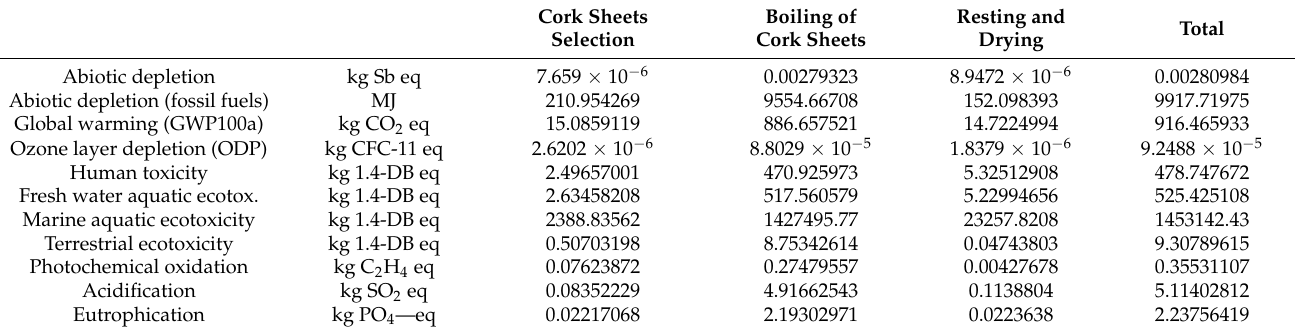
Table 8. Impact of stage 1 broken down by activities for the manufacturing process of 2-piece turned stoppers, of 24 mm in diameter and 44 mm in length.